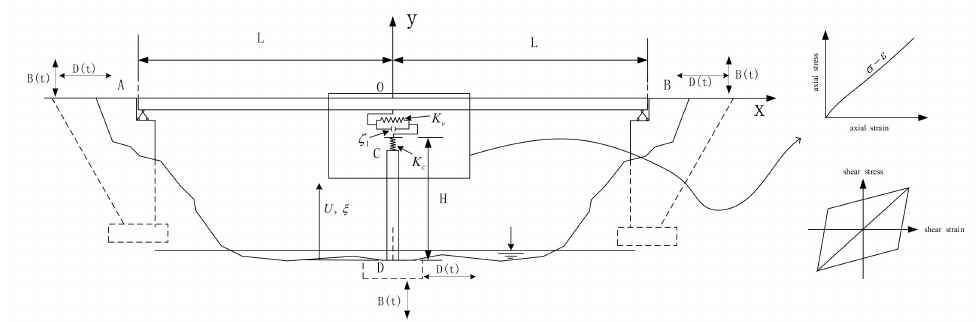
Figure 1. Schematic of double span continuous beam